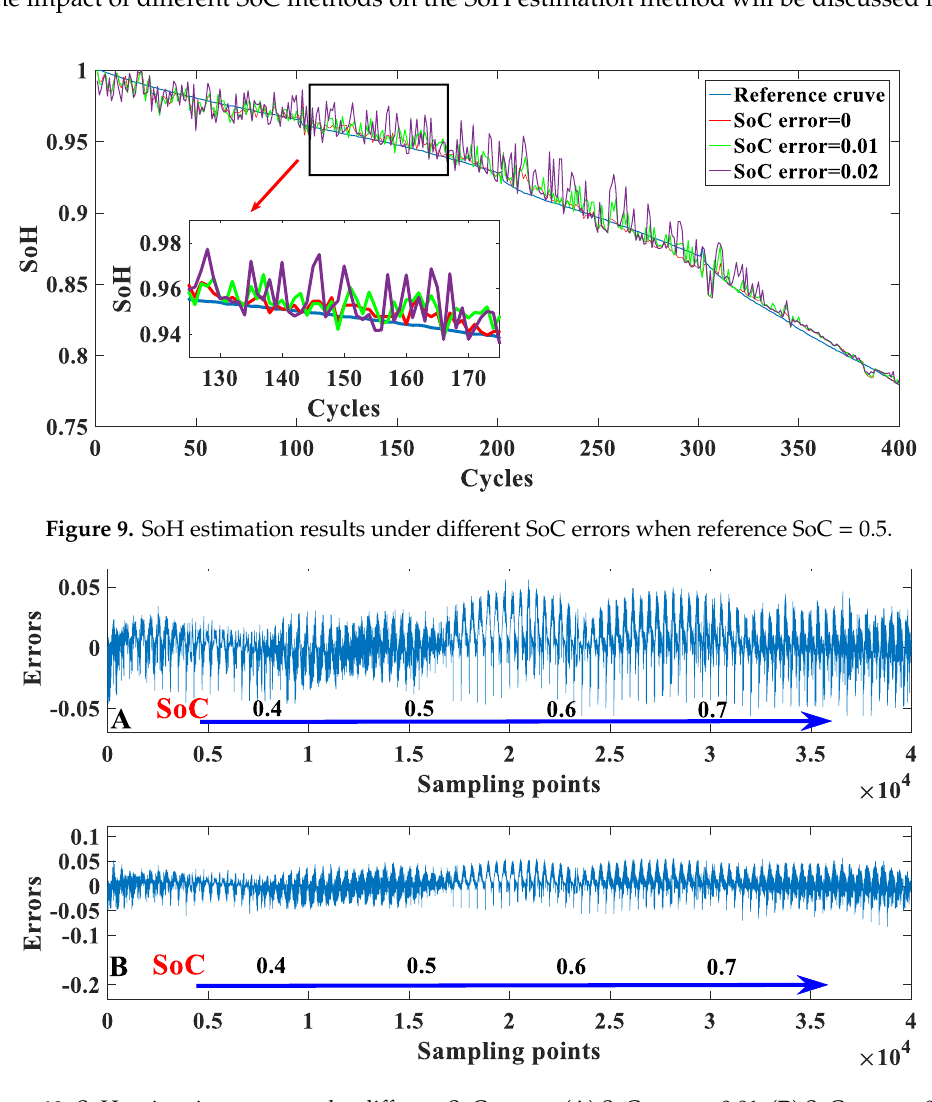
Figure 10. SoH estimation errors under different SoC errors. ( A ) SoC error = 0.01; ( B ) SoC error = 0.02.